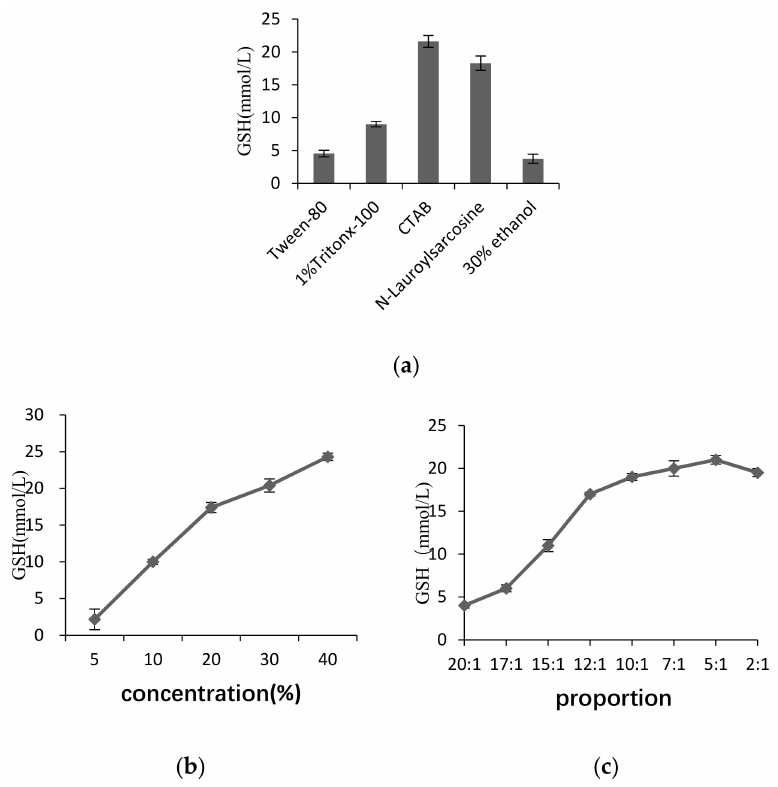
Figure 2. The e ff ect of the permeability of yeast cells on GSH synthesis; ( a ) the e ff ect of the di ff erent types of permeabilizing agents. The permeabilizing agents were Tween-80, 1% TritonX-100, CTAB, N -Lauroylsarcosine, and 30% ethanol; ( b ) the e ff ect of the volume concentration of yeast cells. The yields are shown for the 100 mL reaction system with yeast cell volumes of 5%, 10%, 20%, 30%, and 40%; ( c ) the e ff ect of the proportion of yeast to permeabilizing agent. The proportion of yeast to permeabilizing agent in the reaction system were 20:1, 15:1, 10:1, 5:1, and